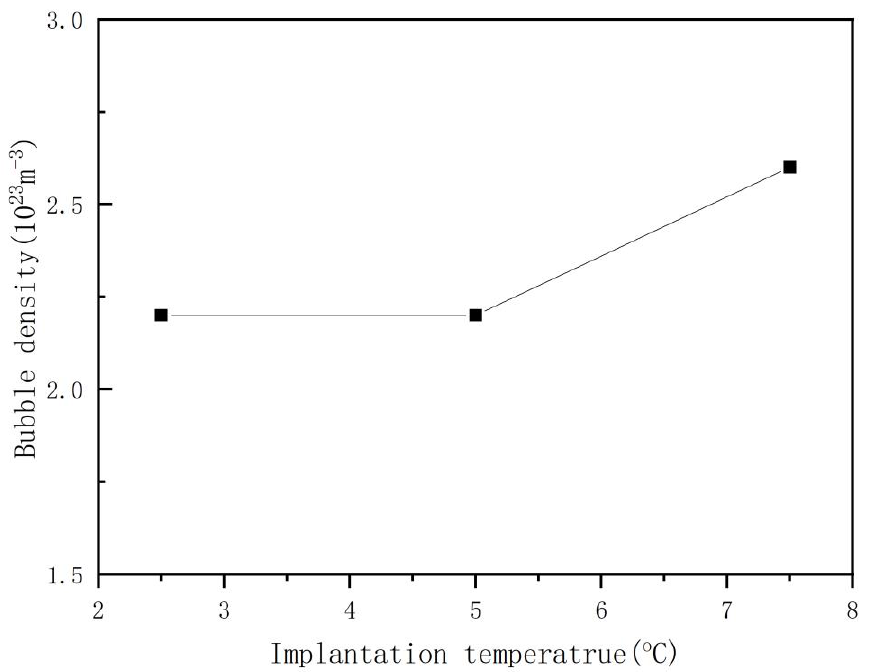
Figure 6. The relationship between helium bubble number density and helium ion implantation dose (helium ion implantation temperature of 180 ◦ C, helium ion of 100